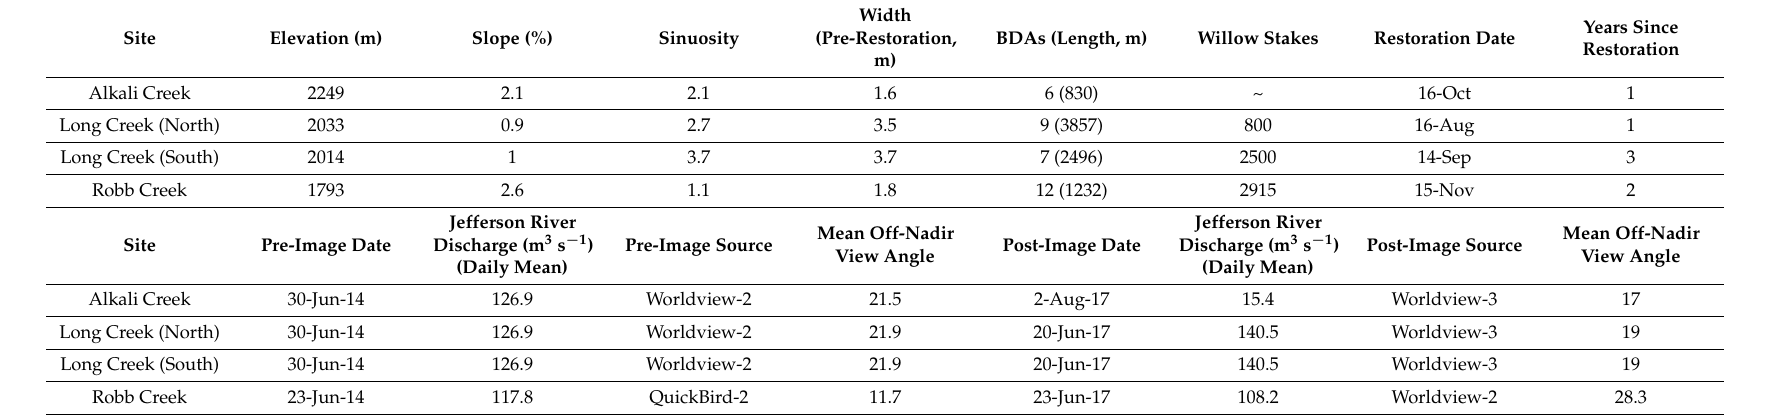
Table 1. Characteristics of the restoration sites and a summary of the restoration activities performed at each site. A list of the high-resolution images representing pre- and post-restoration conditions across the four sites is also shown. Length refers to the stream distance from the most upstream to most downstream beaver dam analog